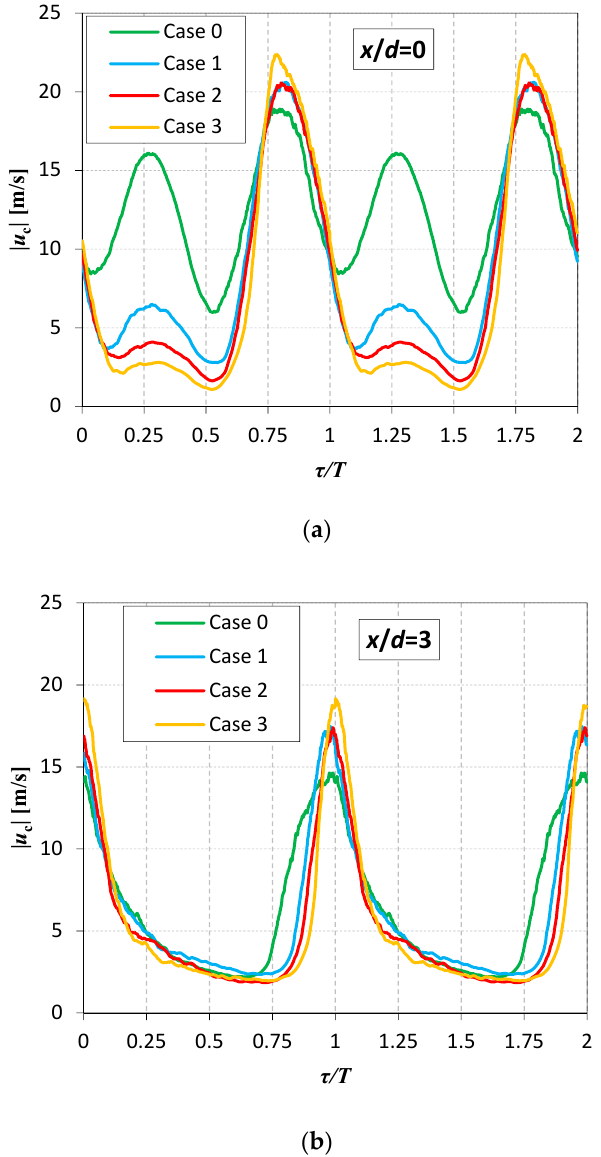
Figure 6. Centerline velocity as a function of time at real power p = 3 W and x / d = 0 ( a ) or x / d = 3 ( b ).